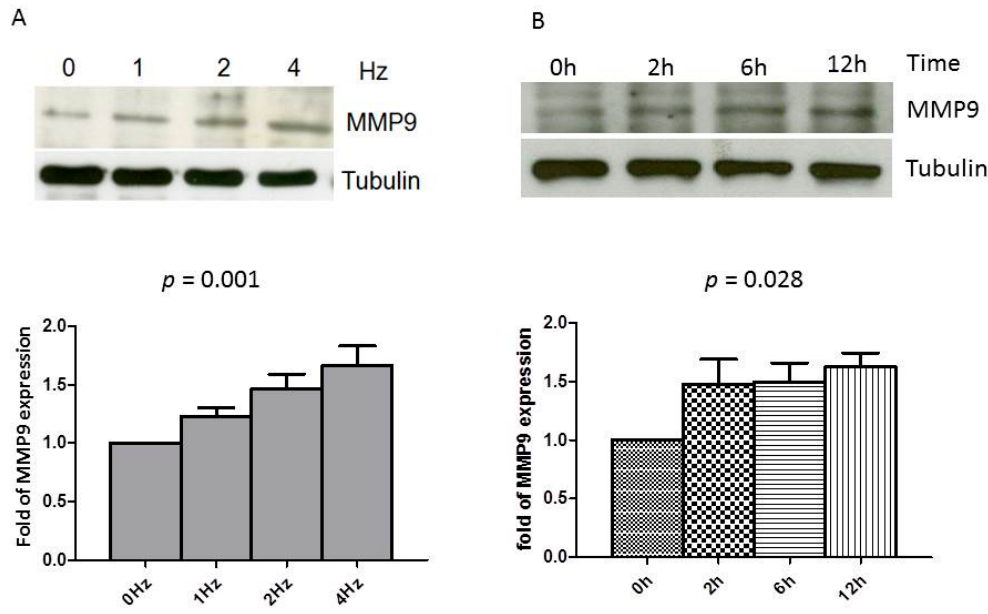
Figure 1. Tachypacing of HL-1 induces MMP9 expression. ( A ) After 24 h of tachypacing HL-1 cells with indicated frequencies, the expression of MMP9 protein was evaluated by Western blot as described in Methods. The expression of tubulin was used as an internal control; ( B ) HL-1 cells were subjected to 4 Hz pacing for the indicated times. ( Bottom ) The relative expression levels of MMP9 and tubulin were quantified by densitometry and normalized to the control level, which was set at 1.0. Each value represents the mean ± standard error (SE) of at least three independent experiments. p value: Dose–response relationships analyzed using one-way ANOVA with linear trend test.